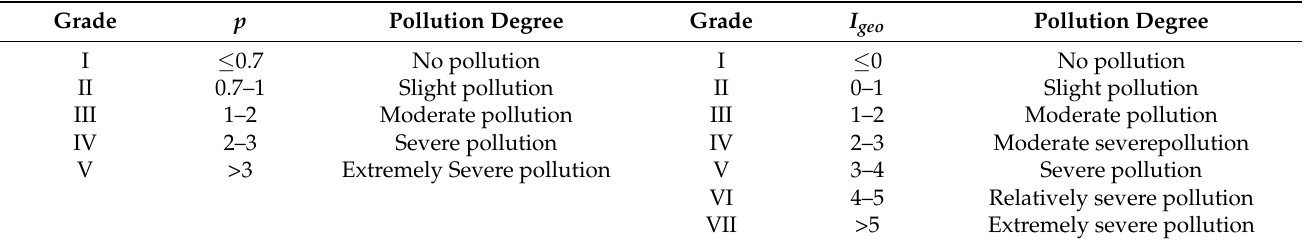
Table 1. Classification of metal pollution degree based on the Nemerow comprehensive pollution index and geo-accumulation